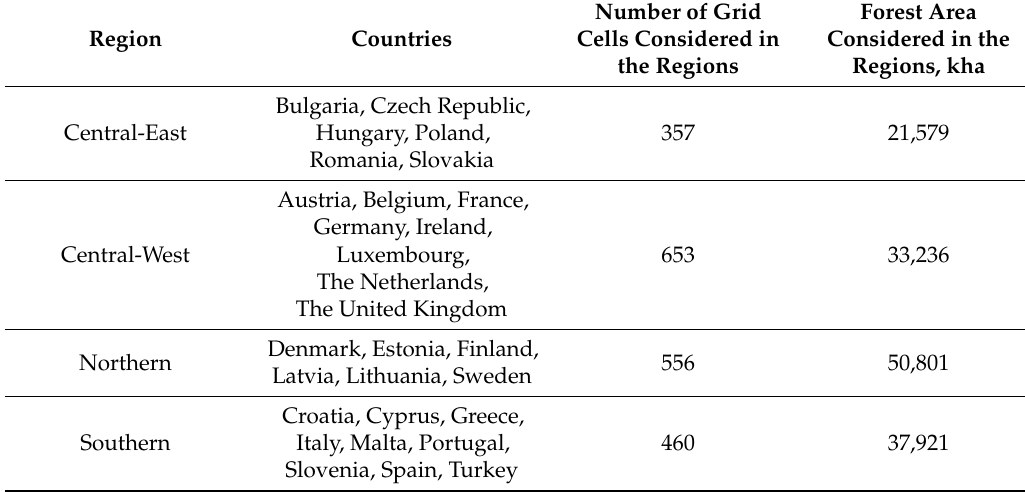
Table 2. Grouping of the countries in study regions, number of grid cells and forest area considered in the study.